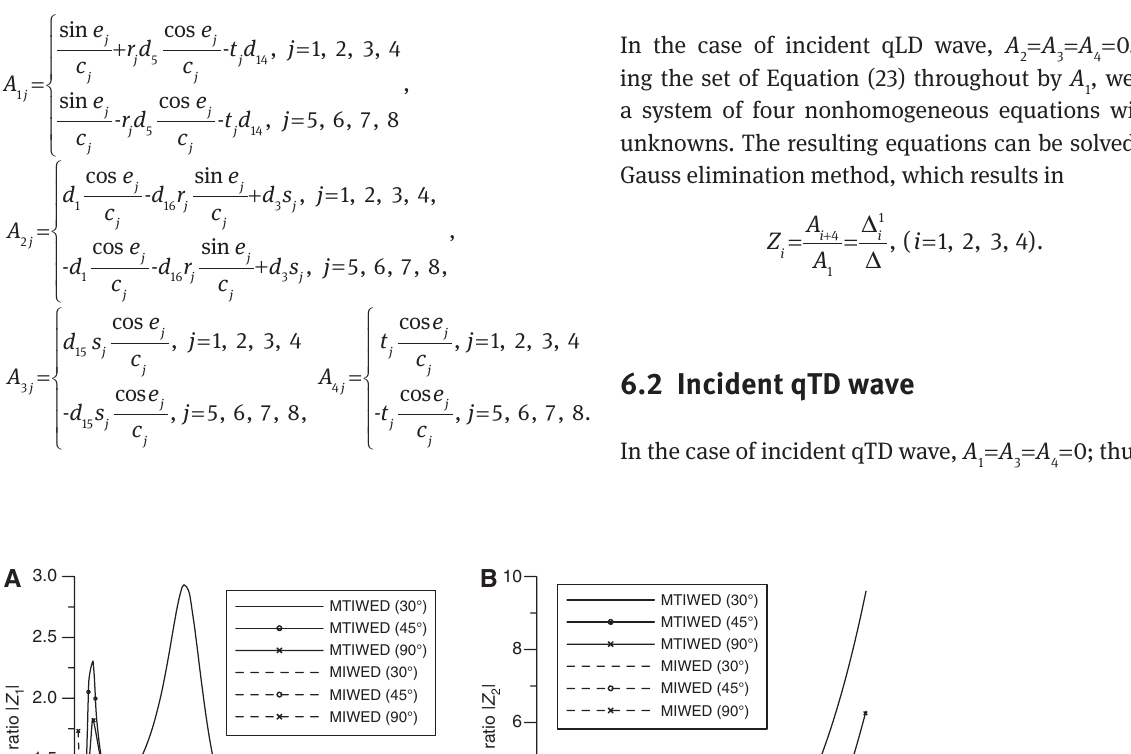
| when qLD wave is 4